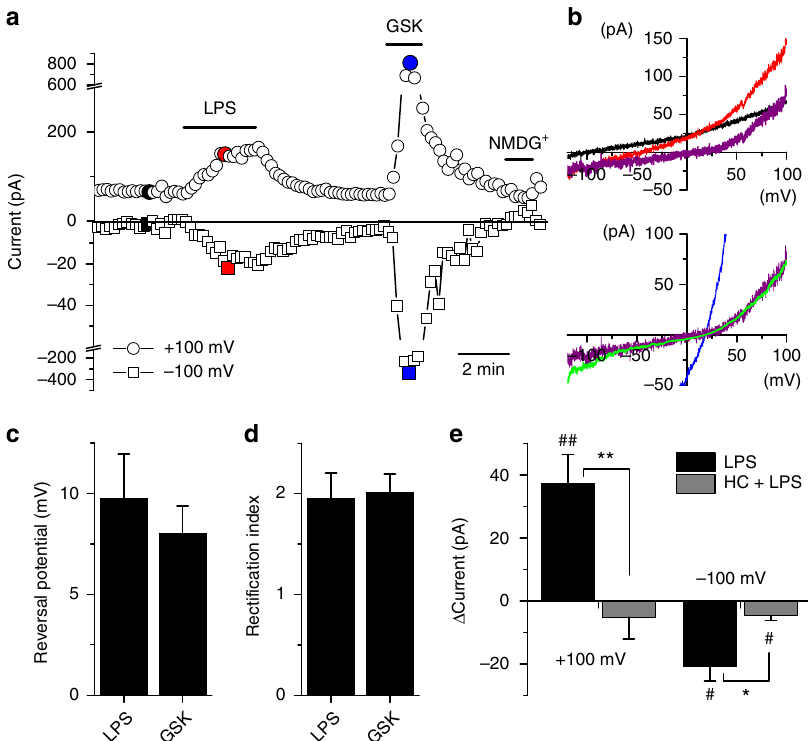
Fig. 2 LPS activates TRPV4. a Example of the effects of LPS on the amplitude of currents measured at +100 and − 100 mV in a HEK293T cell transfected with mTRPV4. The colored data points correspond to the traces shown in ( b ). b Top, currents recorded in control (black trace) or in the presence of LPS (20 µ g ml − 1 , red trace). The purple trace represents the difference of the red and black traces, i.e., the current induced by LPS. Bottom, comparison of the currents induced by LPS and GSK1016790A (10 nM, blue trace). The green trace represents the GSK1016790A-evoked current normalized to the amplitude of the LPS-evoked current measured at +100 mV. c , d Average reversal potential ( c ) and recti fi cation index ( d ) of currents induced by application of LPS or GSK1016790A ( n = 11). e Average change of current amplitudes induced by the application of 20 µ g ml − 1 LPS ( n = 11) or 20 µ g ml − 1 LPS in the presence of 10 µ M HC067047 ( n = 7). # represents the comparison to Δ Current = 0 pA. # P < 0.05; ## P < 0.01 ( n = 6), one sample t -test. * P